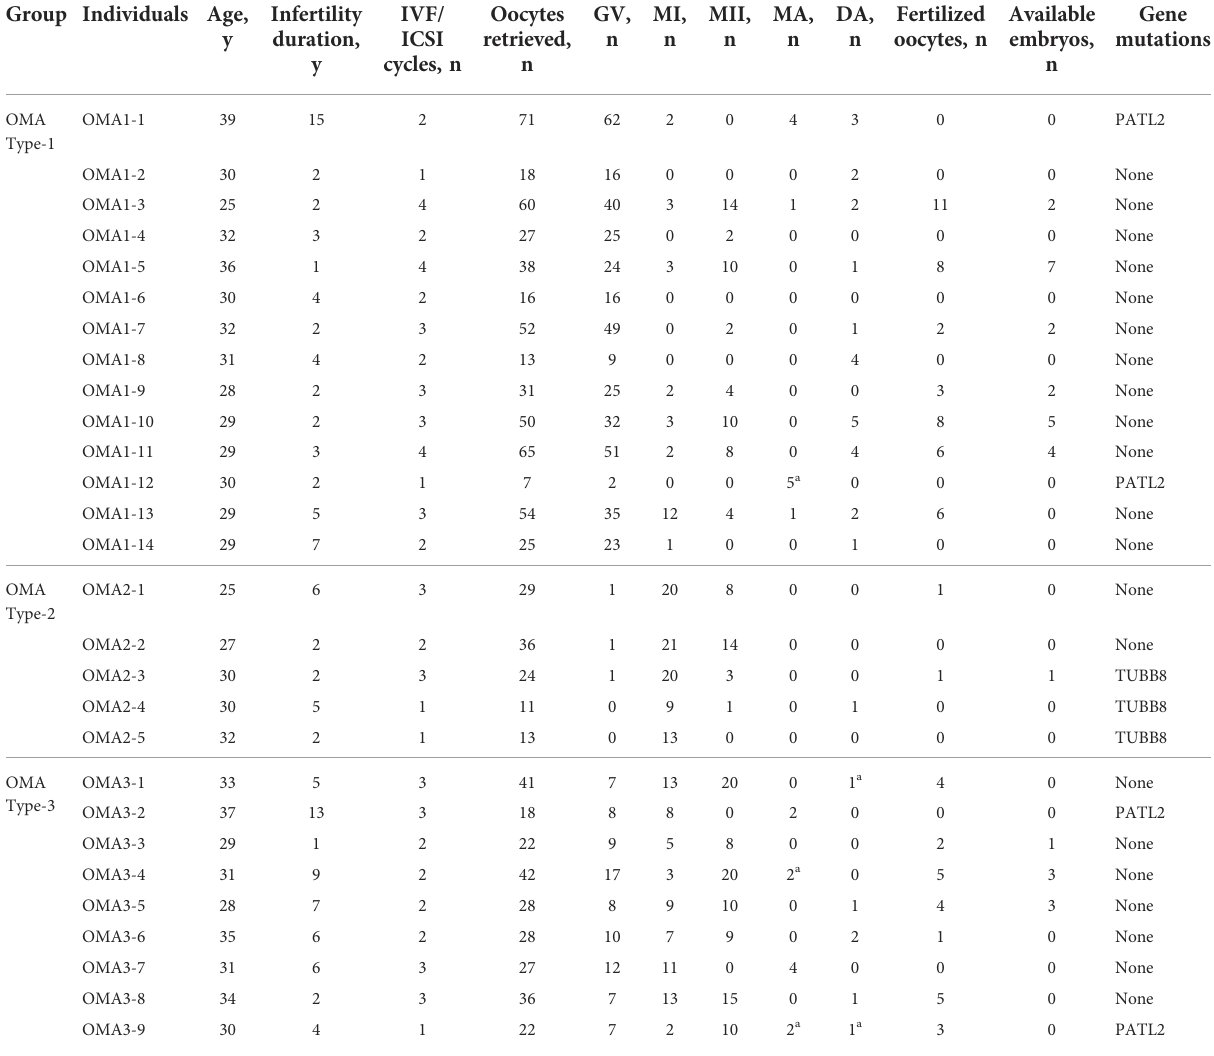
TABLE 1 Clinical characteristics of involved individuals and oocyte phenotype. Group Individuals Age,